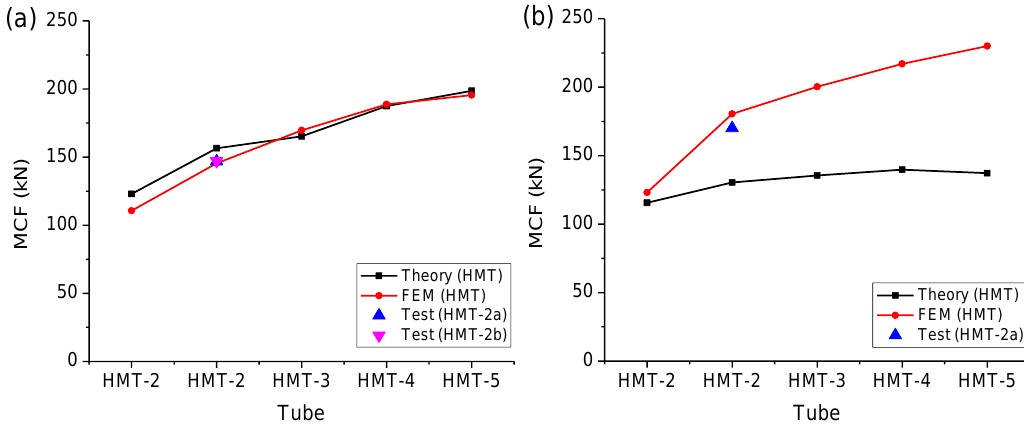
Figure 16. Predicted MCFs based on ( a ) the PF method and ( b ) the tangent method. Table 9. Theoretical predicted MCFs for HMTS based on PF method. The tangent method will include part of the energy absorbed in the